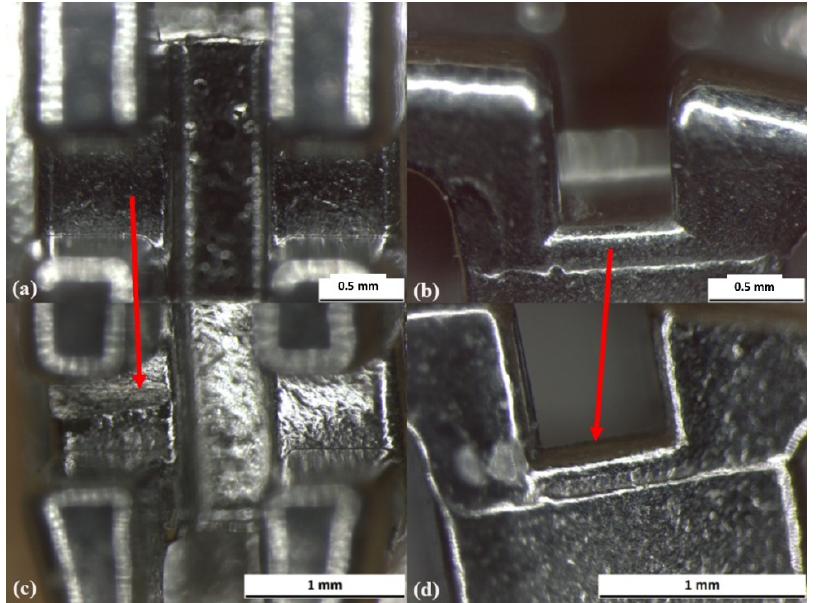
Figure 9. Vesper Plus bracket (Micerium Orthodontics) in top and side view: ( a , b ) before the test; ( c , d ) after the test.